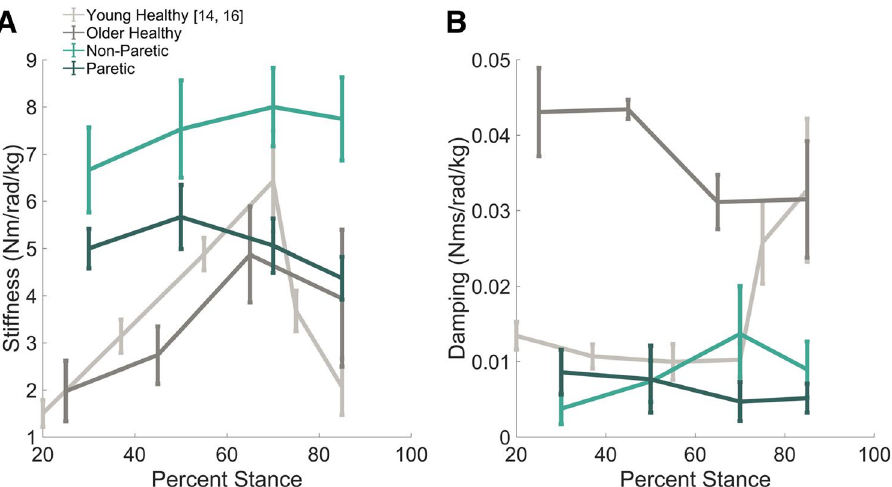
Figure 1. Average inter-subject stiffness ( A ) and damping ( B ) as a function of stance phase. Ankle impedance estimates during walking of individuals with chronic stroke are indicated in dark green (paretic limb) and light green (non-paretic limb). Dark grey traces indicates impedance estimates of three gait-speed matched older adults without stroke, within a similar age range to participants with chronic stroke. Light grey traces present impedance as a function of stance phase for young healthy adults walking at a faster speed from previous literature. Stiffness for stroke participants was constant across the stance phase of walking and did not demonstrate the stereotypical increase in mid-stance that prepares for forward propulsion for either limb. Stiffness of the non-paretic limb was significantly larger than the paretic limb, and both were increased compared to age and gait-speed matched controls. Older adults walking at a slower pace exhibited a similar pattern of stiffness variation to young healthy adults with a lower peak stiffness in mid-stance. Damping did not vary significantly across stance phase for either limb of stroke participants or age and gait-speed matched